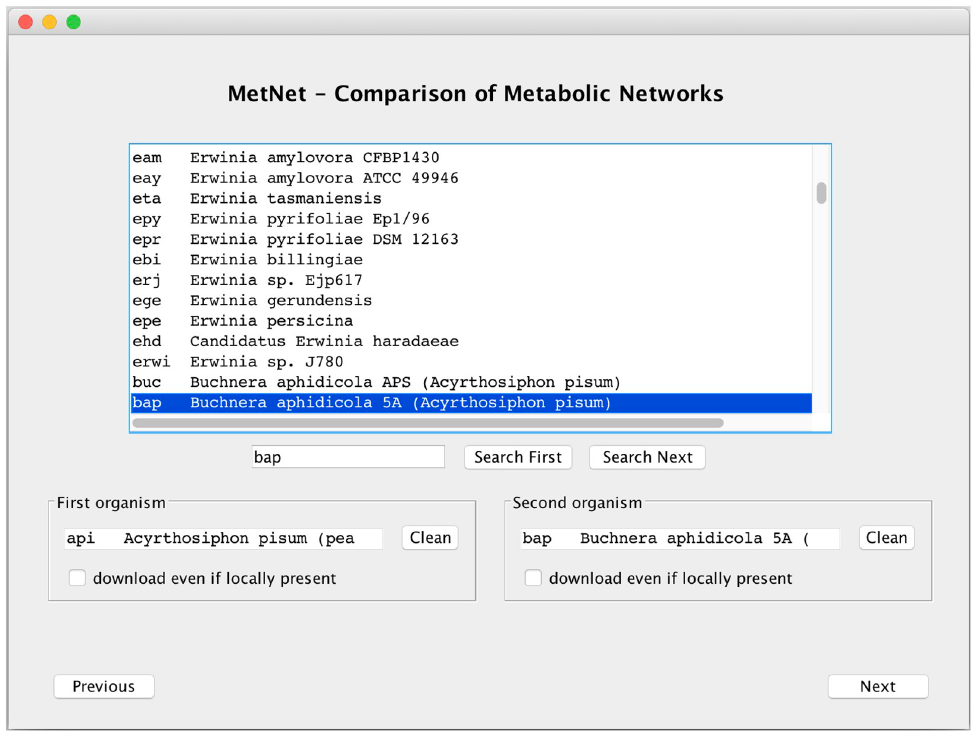
Fig 3. Organisms selection window: Example for api and bap